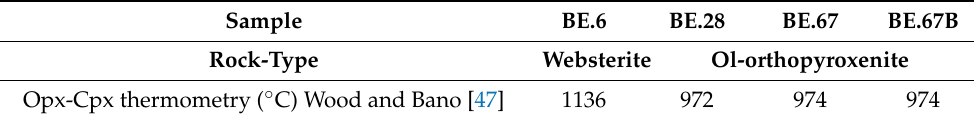
Table 6. Temperature (T ◦ C) estimates on pyroxenites from the Veria-Naousa ophiolite. Sample